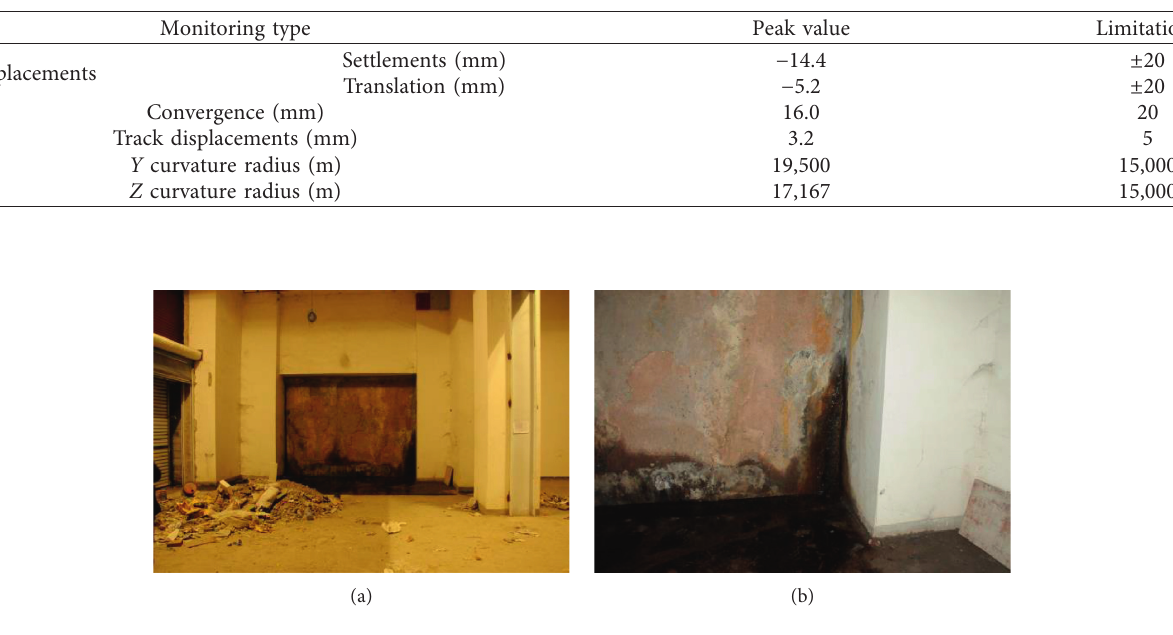
Figure 13: Variations in tunnel convergence: (a) westbound tunnel and (b) eastbound tunnel. Table 1: Monitoring peak value against limitations.